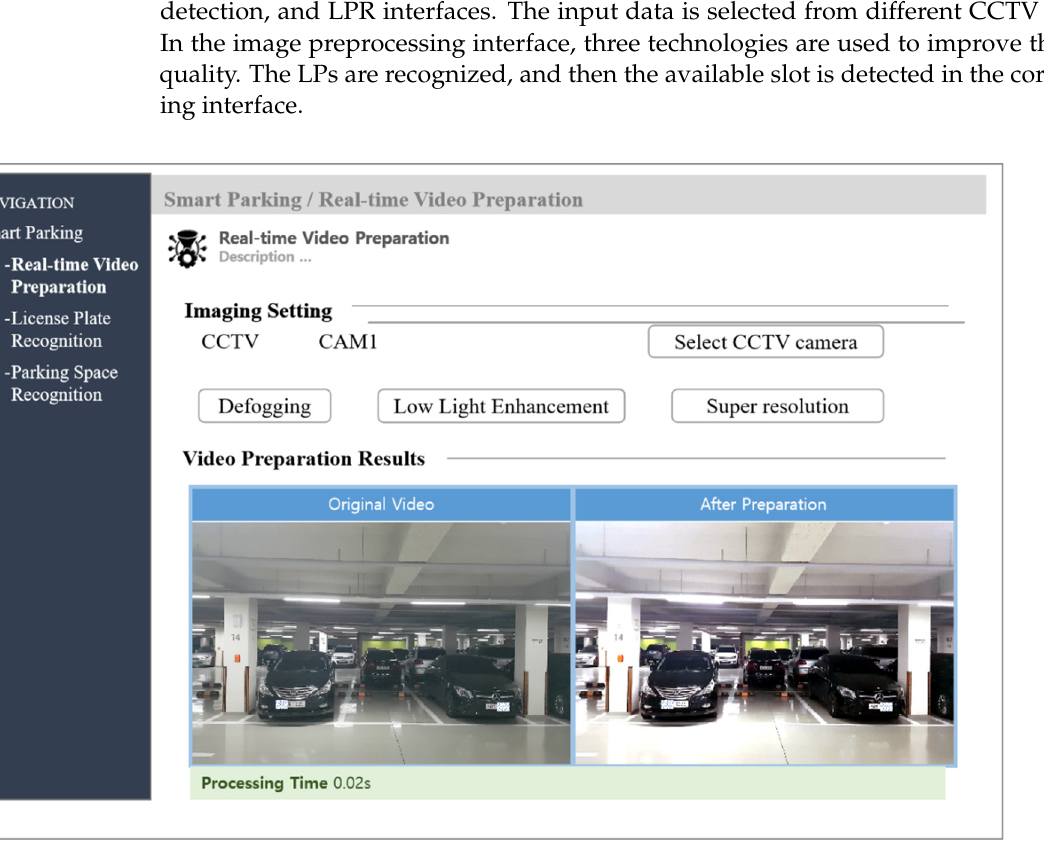
Figure 5. The graphical user interface of the proposed system.